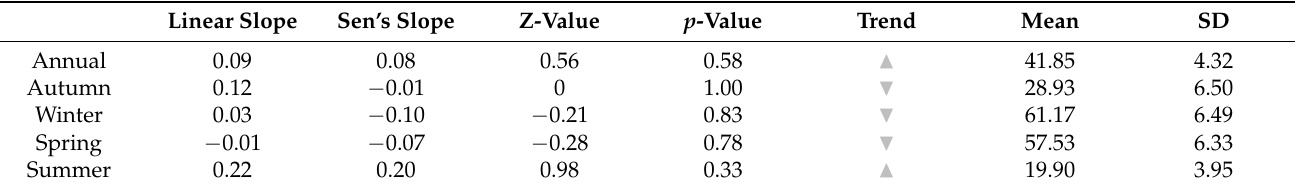
Figure 12. Seasonal and annual MODIS SCA and trends in relation to slope across all subregions over the observation period of 2000–2019. Table 2. Annual and seasonal Mann–Kendall test statistics of the mean SCA (%) in the study area of Ladakh from 2000 to